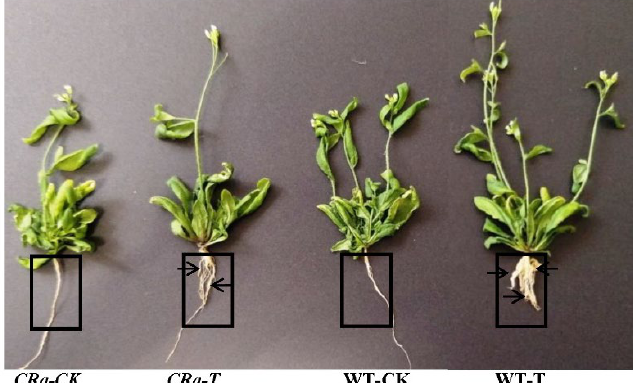
Figure 6. Root expression of T 2 CRq transgenic and wild-type Arabidopsis thaliana after 28 days of inoculation. CRq- CK: T 2 generation of transgenic A. thaliana control plants; CRq- T: T 2 transgenic A. thaliana was infected with P. brassicae ; WT-CK: Wild-type Arabidopsis control plant; WT-T: Wild-type Arabidopsis was infected with P. brassicae . The black arrows indicate the degree of root enlargement.